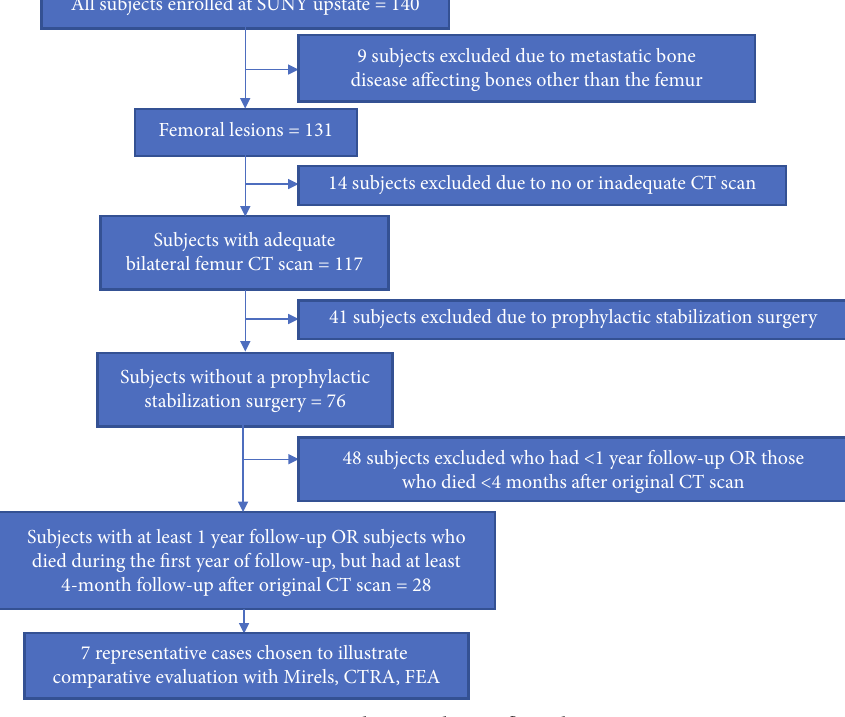
Figure 1: Subject exclusion flow